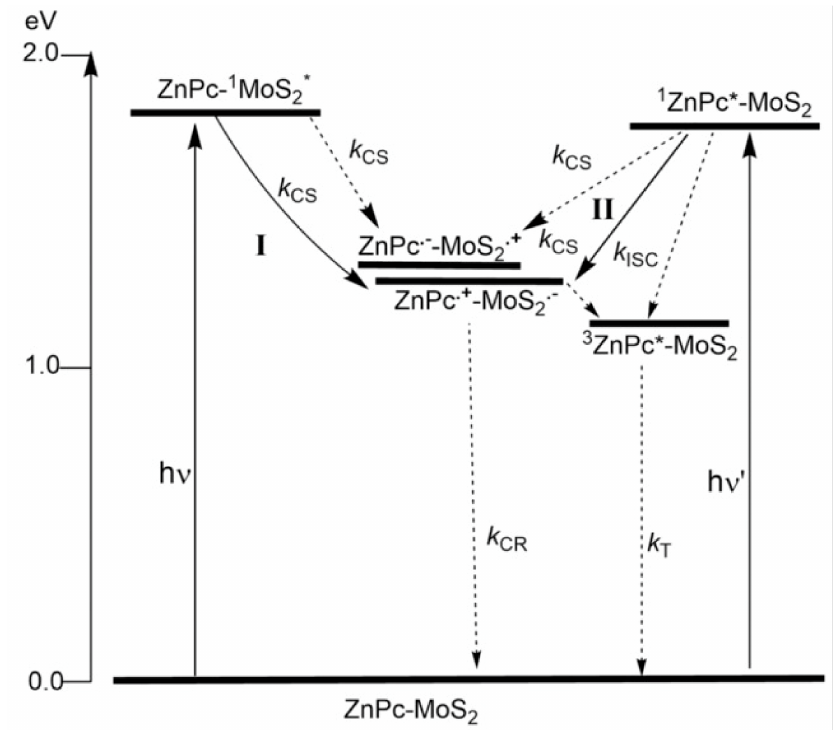
Figure 8. Energy-level diagram showing possible photochemical processes occurring in the Pc 16 -MoS 2 hybrid material. Solid arrows show major processes; dashed arrows show minor ones. Adapted with permission from ref [118]. Copyright 2019 John Wiley and